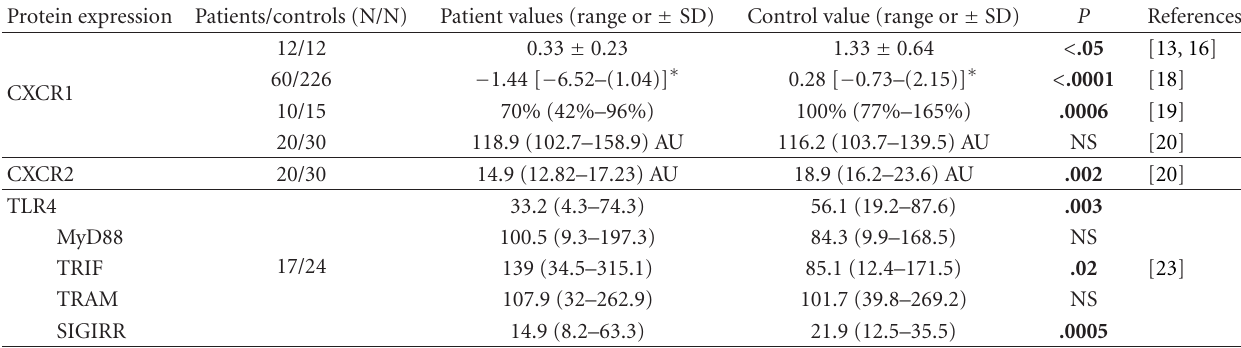
Table 3: Comparison of the gene expression of patients with recurrent urinary tract infection and controls. (CXCR: IL-8 receptors; MyD88: myeloid di ff erentiation primary response gene 88; SIGIRR: single immunoglobulin domain-containing IL-1 receptor–related molecule; TLR: Toll-like receptor; TRAM: TIR domain–containing adaptor inducing IFN- β -related adaptor molecule; TRIF: TIR domain–containing adaptor inducing INF- β